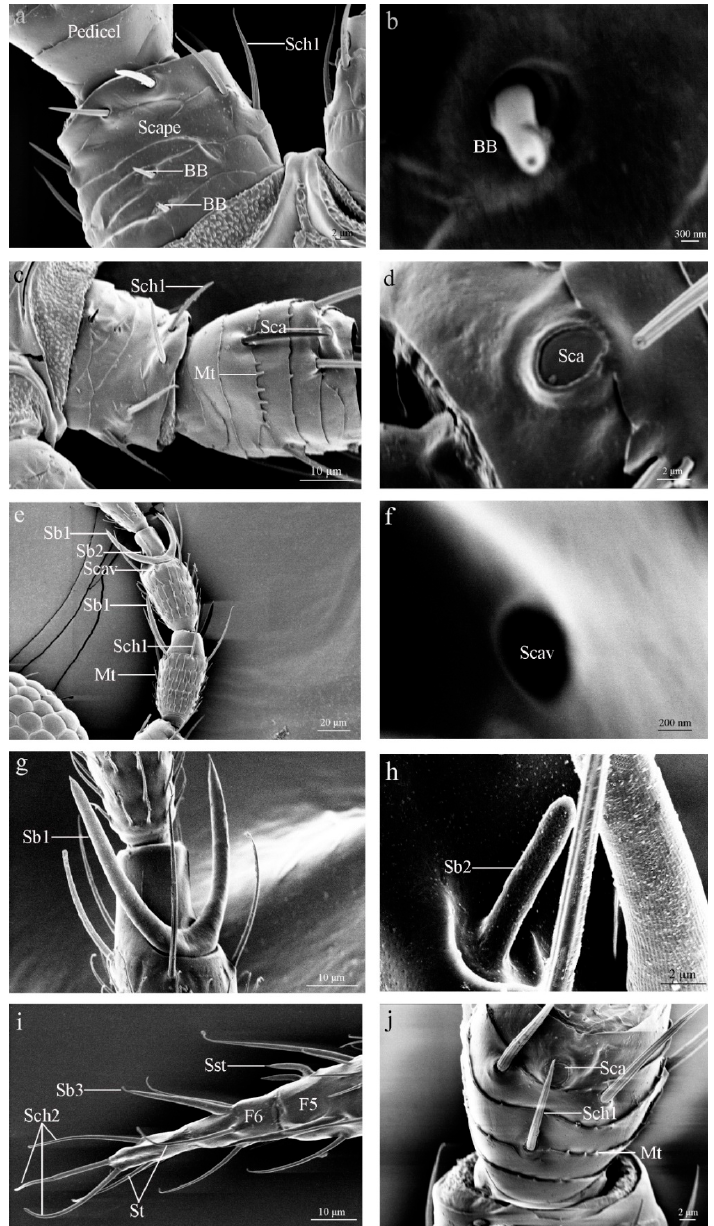
Figure 2. Scanning electron microscopy micrographs describing the different features of the antennae sensilla of Megalurothrips usitatus (Bagnall). ( a ) Böhm bristle (BB) and sensilla chaetica 1 (Sch1) were found on scape. ( b ) The morphology of Böhm bristle (BB). ( c ) Sensilla campaniformia (Sca), sensilla chaetica 1 (Sch1) and microtrichia (Mt) were found on scape and pedicel. ( d ) The morphology of sensilla campaniformia (Sca). ( e ) Sensilla cavity (Scav), sensilla chaetica 1 (Sch1), sensilla basiconica 1 (Sb1), sensilla basiconica 2 (Sb2) and microtrichia (Mt) were found on the F1 and F2 of flagellum. ( f ) The morphology of sensilla cavity (Scav). ( g ) The morphology of sensilla basiconica 1 (Sb1). ( h ) The morphology of sensilla basiconica 2 (Sb2). ( i ) Sensilla chaetica 2 (Sch2), sensilla basiconica 3 (Sb3), sensilla styloconica (Sst) and sensilla trichodea (St) were found on the F5 and F6 of flagellum. ( j ) Sensilla campaniformia (Sca) were found on